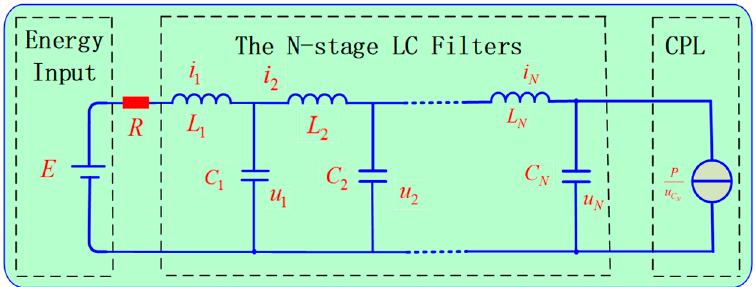
Figure 5. Topology structure of a DC microgrid with N ‐ stage LC filters.